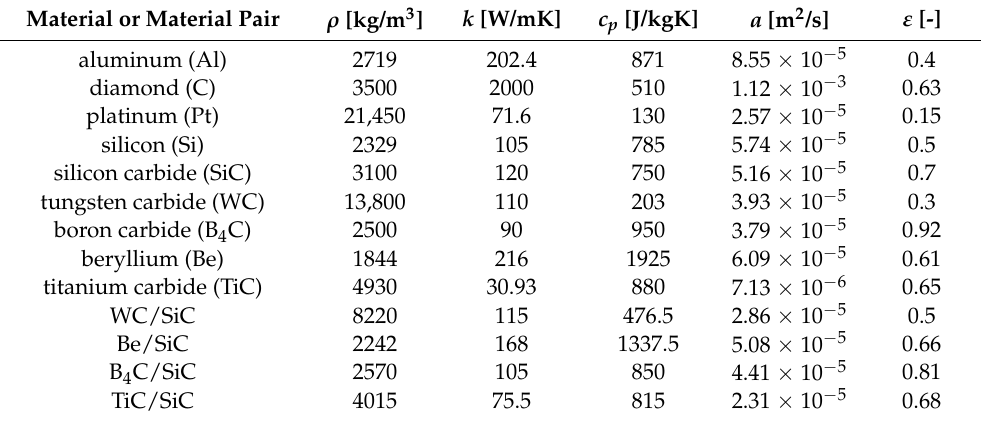
Table 1. Bulk materials properties of elements, compounds, and multilayer pairs: density ρ , thermal conductivity k , specific heat capacity c p , thermal diffusivity a , surface emissivity ε